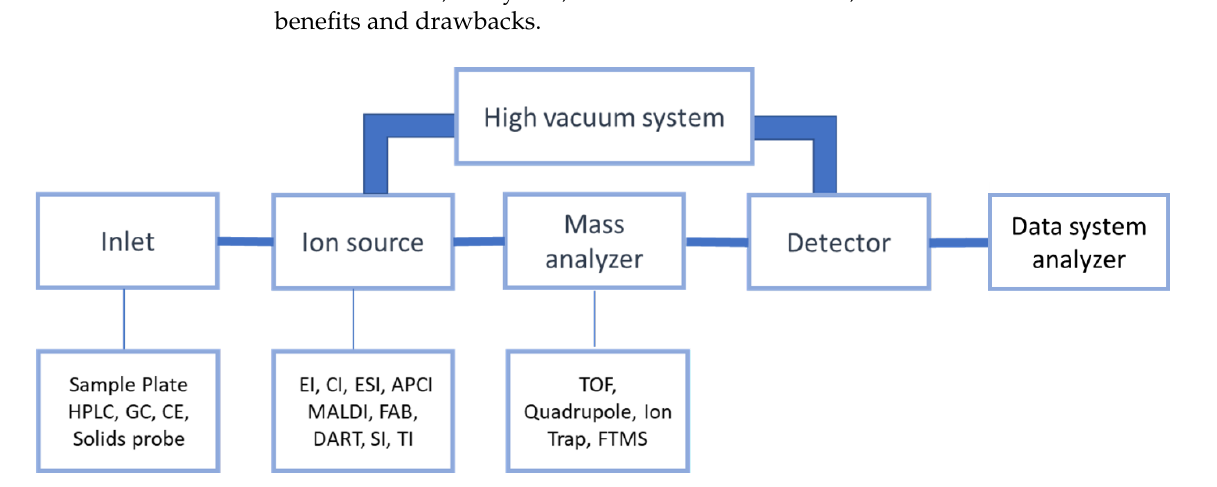
Figure 1. Essential parts of an MS device.